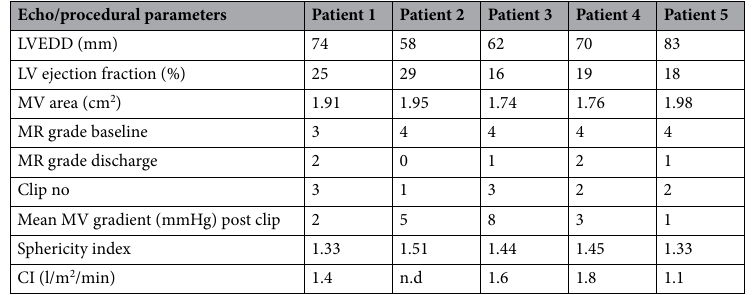
Table 4. Echocardiographic and procedural data. LVEDD left ventricular enddiastolic diameter, MV mitral valve, MR mitral regurgitation.